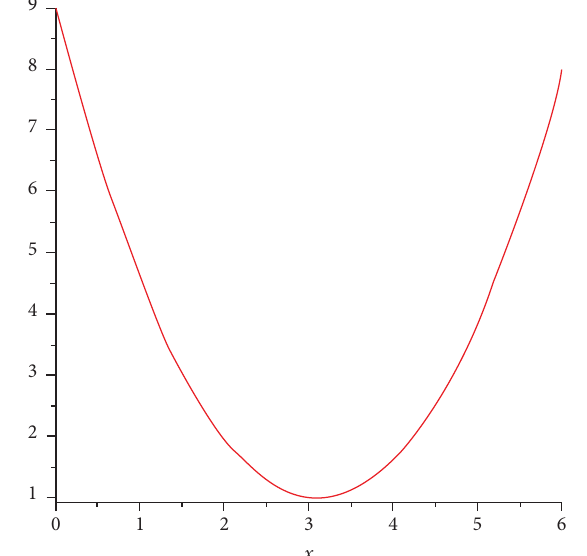
Figure 8: Impact of shape parameters t and as it moves away from connecting point.